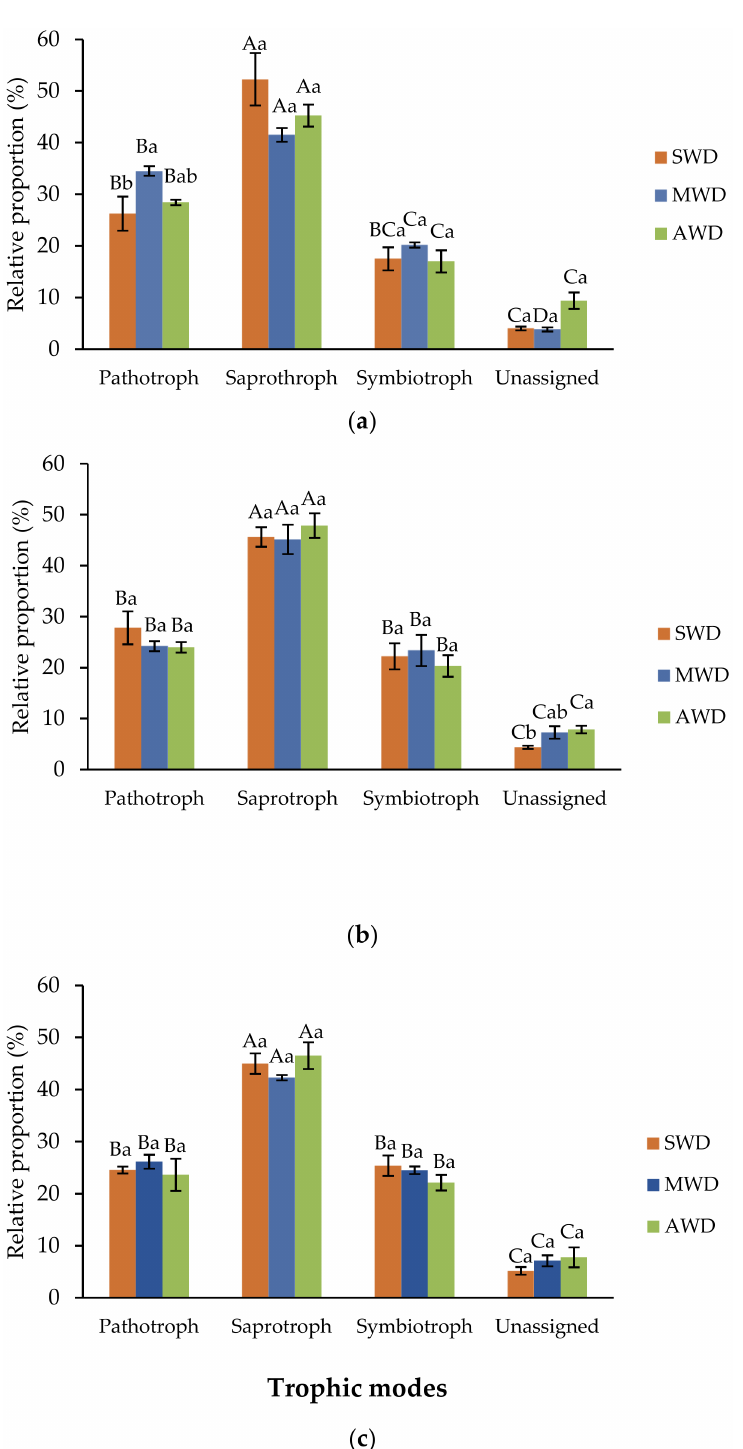
Figure 10. Variations in fungal function inferred by FUNGuild in in the ( a ) root, ( b ) rhizozphere and ( c ) bulk soil, at different irrigation regimes: severe water deficit (SWD), moderte water deficit (MWD), and absence of water deficit (AWD). Tukey’s test at p -value < 0.05 level. Means followed by the same letter do not differ significantly. Capital letters are for comparison of means among functional groups within each irrigation regime. Small letters are for comparison of means among irrigation regimes within each functional